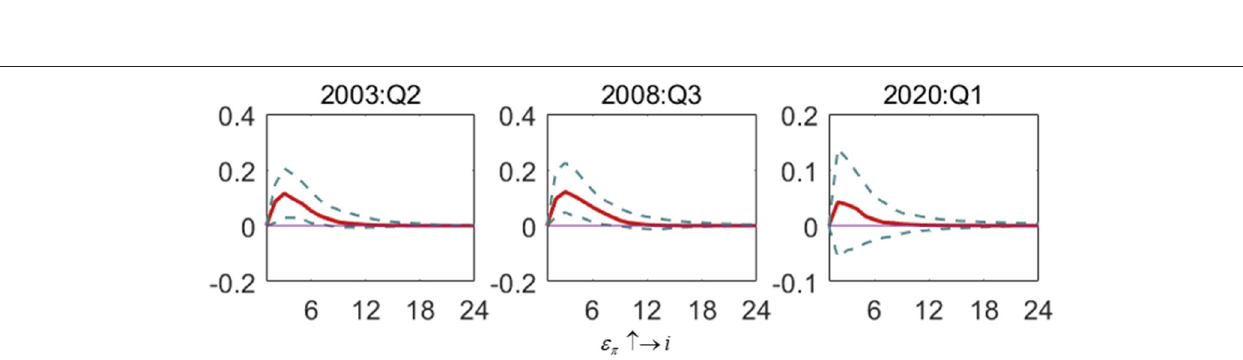
FIGURE 5 | The impulse response of the inflation gap to output gap shock in special periods. Each subfigure demonstrates three special periods, including the SARS outbreak period (2003:Q2), the global financial crisis period (2008:Q3) and the COVID-19 outbreak period (2020:Q1 ). One period in the figure denotes one season.